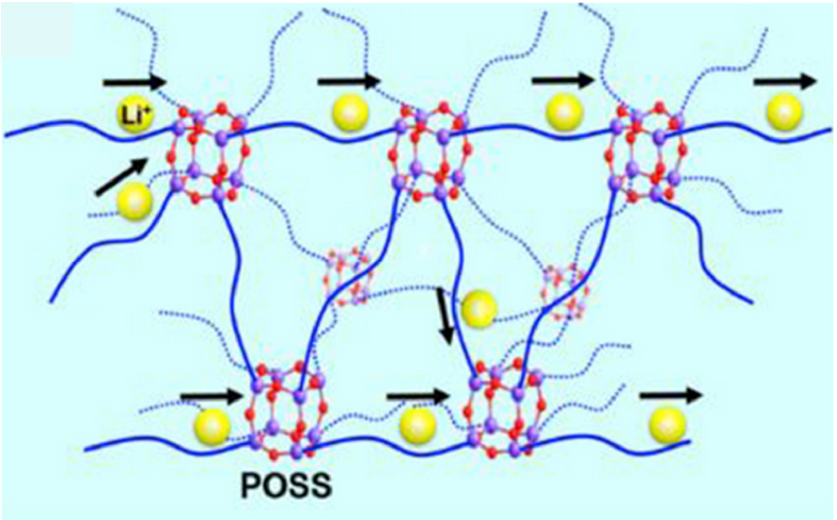
Figure 4. Lithium-ion transport in POSS and PEO-co-PPO polymer electrolyte. The PEO-co-PPO chains are straightened and kept apart by the POSS hub which facilitates lithium motion. Journal of Power Sources,